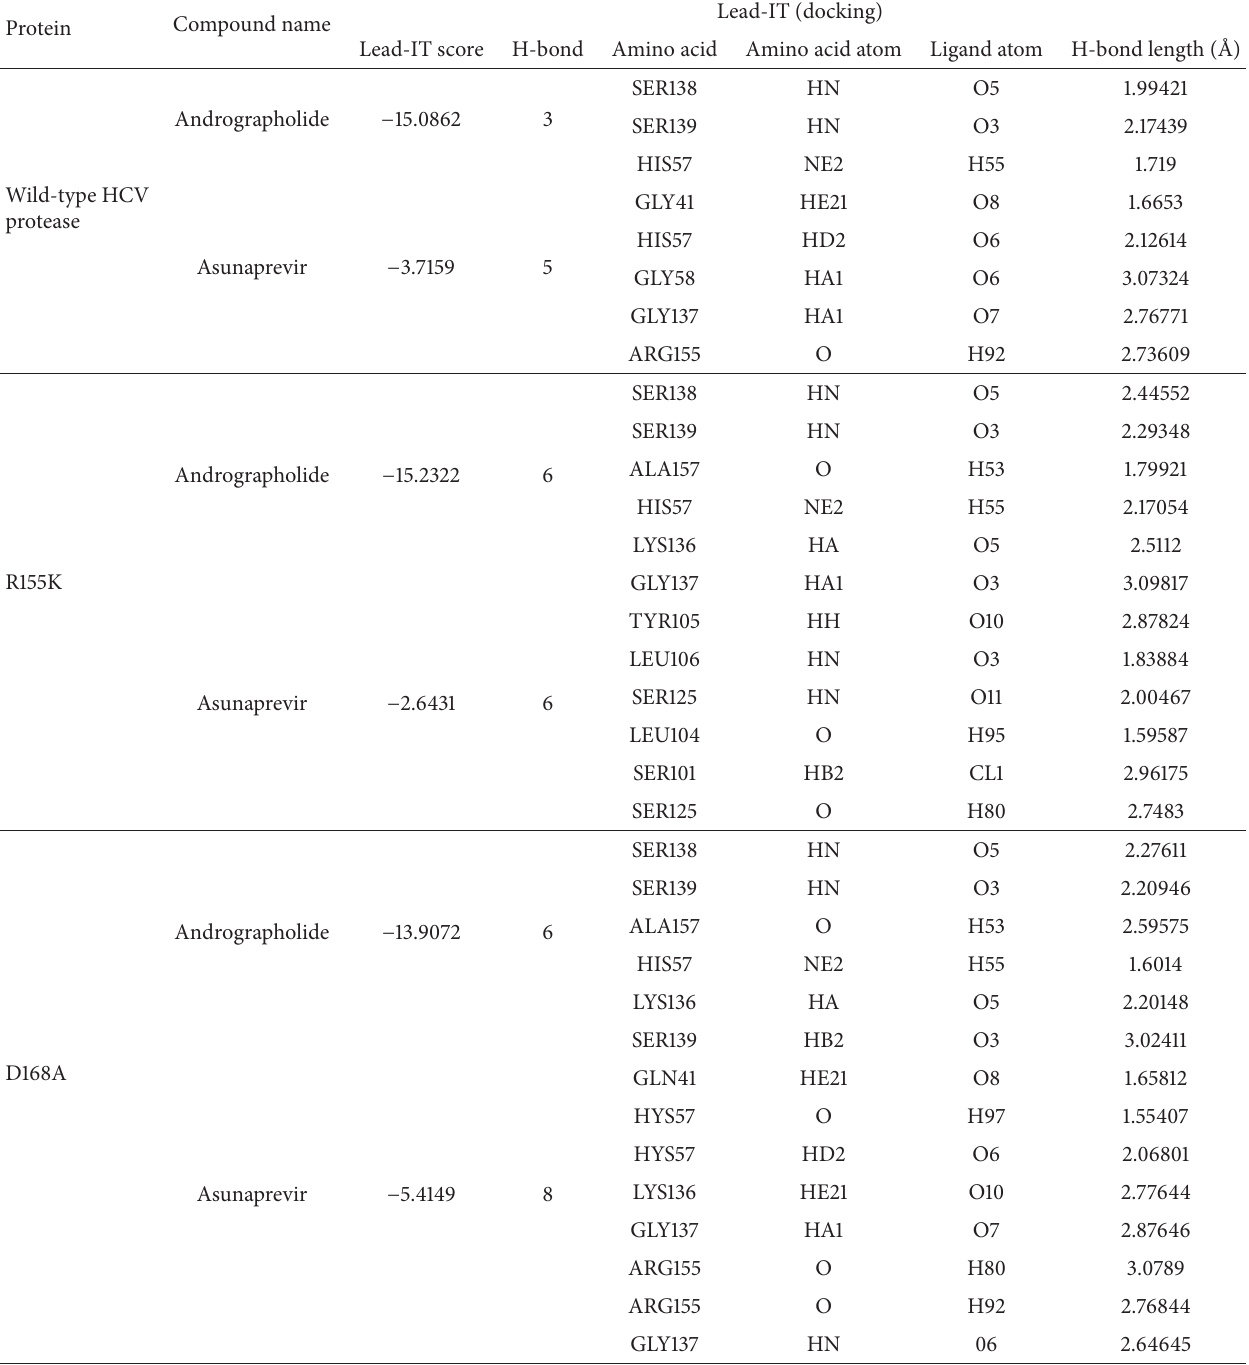
Table 4: Ligand-protein interaction with docking